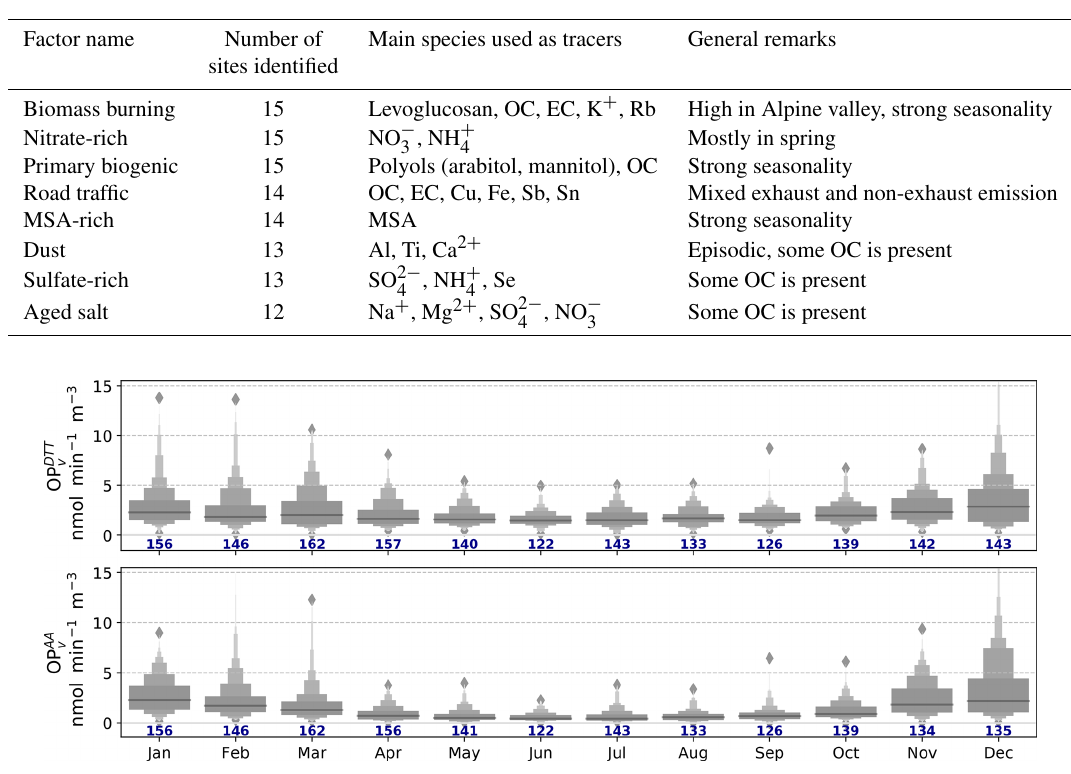
Table 1. Main PMF factors identified (at least at two-thirds of the series, i.e., 10 out of 15) and species used as proxies for the determination.